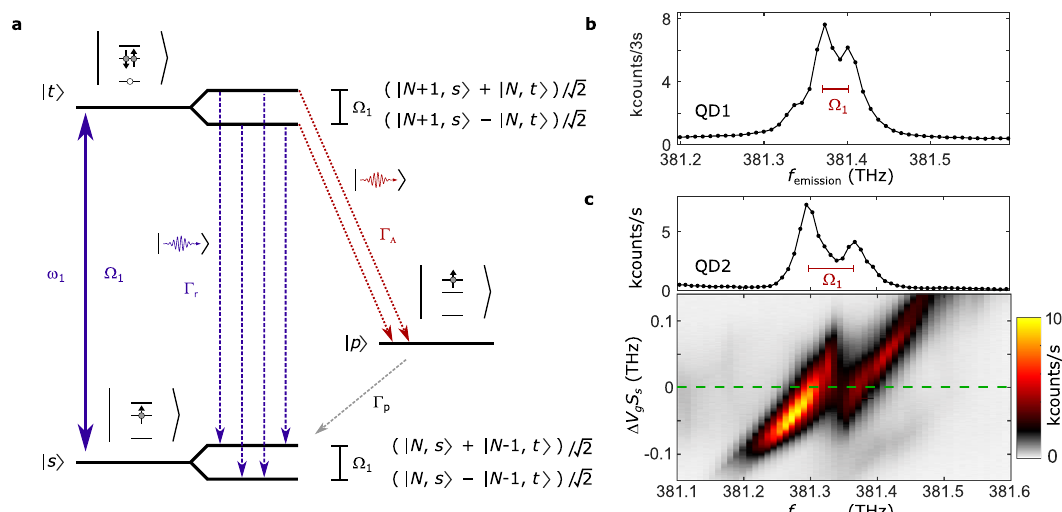
Fig. 2 Autler – Townes splitting in the radiative Auger emission. a Level scheme under strong resonant driving of the fundamental transition ( s j i − t j i ). The energy levels of the transition are split into dressed states. The splitting between the dressed states is given by the Rabi frequency, Ω 1 . In the radiative Auger emission (red arrows), the dressed-state splitting creates two decay paths leading to an Autler – Townes splitting. b Radiative Auger emission from the main quantum dot (QD1) on driving the transition s j i − t j i with ω 1 . The Rabi frequency of Ω 1 = 2 π × 31.9 GHz (red bar) is determined from a power saturation curve. The measured Autler – Townes splitting in the emission matches the Rabi frequency. c Emission spectrum from a second quantum dot (QD2), measured for a set of different detunings ( Δ 1 = Δ V g ⋅ S s ) between fundamental transition and laser frequency. The upper part of the plot is a line cut along the dashed green line at zero detuning ( Δ 1 = 0). In this case, the measured Autler – Townes splitting agrees with the independently determined Rabi frequency ( Ω 1 = 2 π × 67.7 GHz).